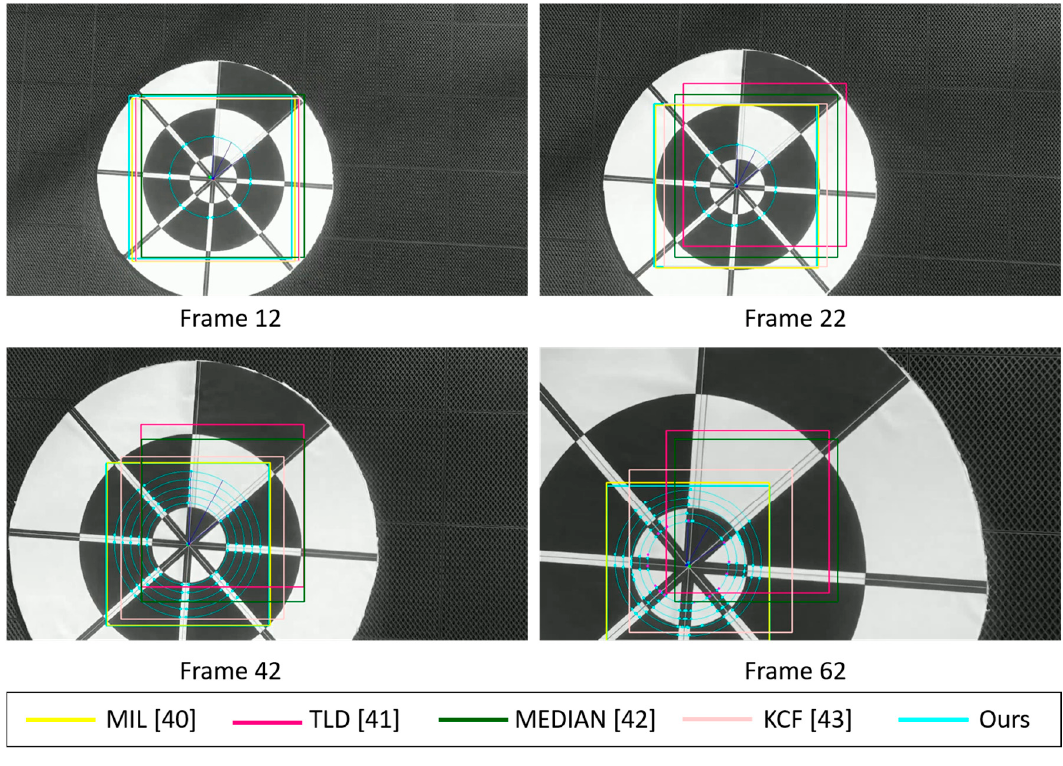
Figure 13. Comparisons of CLE and PDE obtained by our method with those obtained by other methods using sub-database 2 including the videos captured ( a ) in the morning, ( b ) in the afternoon, ( c ) in the evening, and ( d ) at